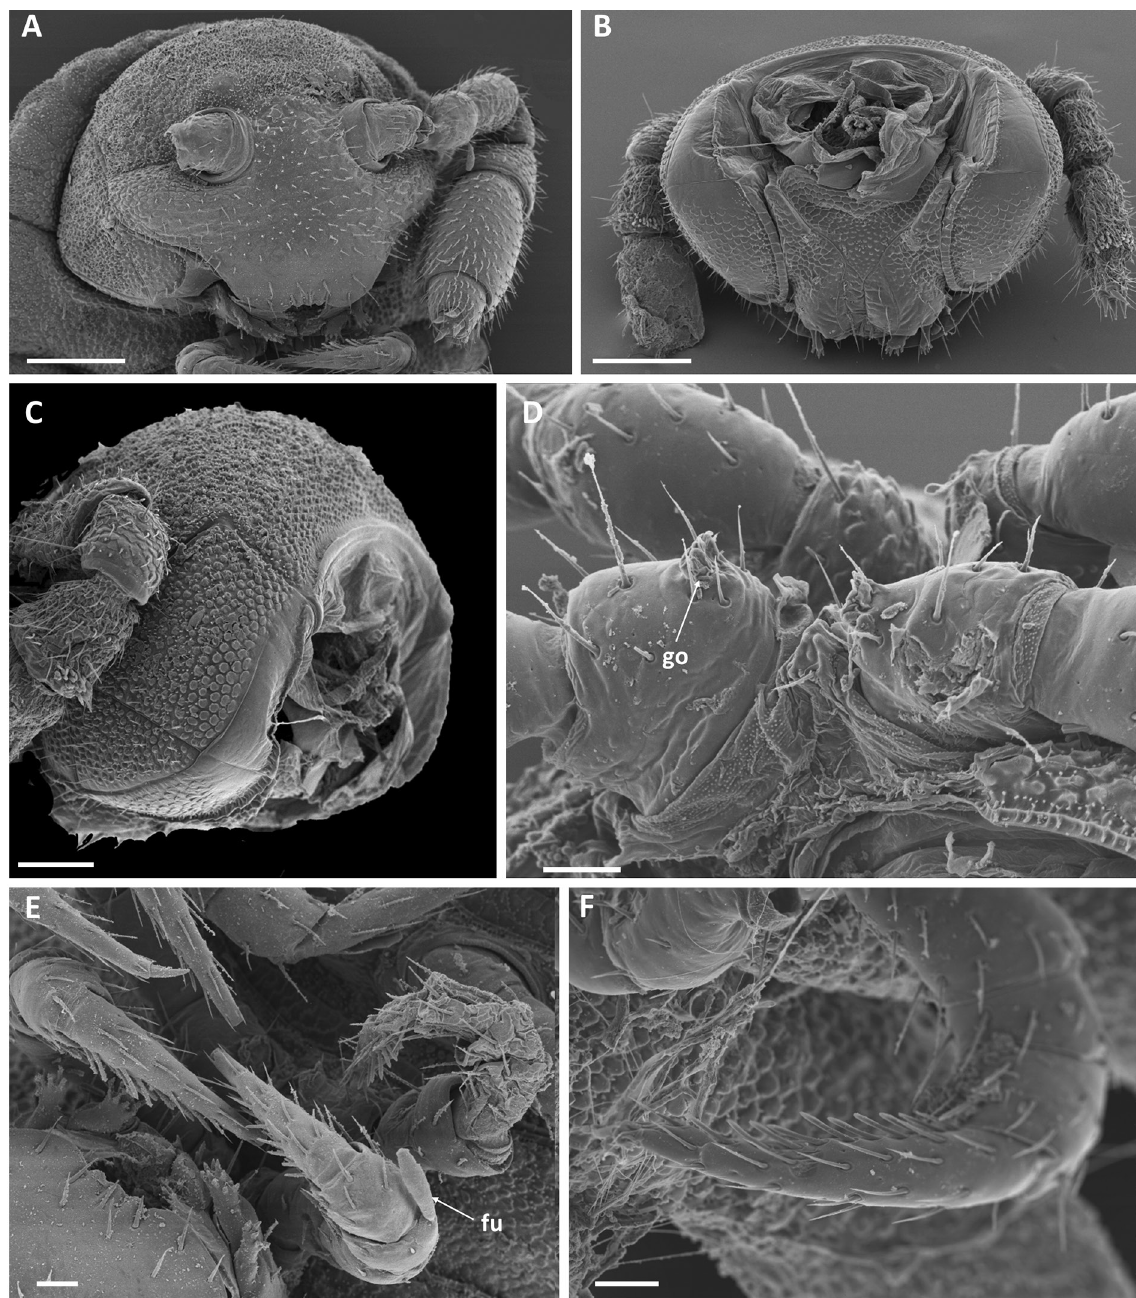
Fig. 2. Cryptocorypha geminiramus sp. nov. A–E . Paratype (NHMD 621824), ♂, from Kidatu. F . Paratype (NHMD 621829), ♂, from Mitu Mitato. A . Head, frontal view. B . Head, (sub)posterior view. C . Head, sublateral view (left side). D. Bases of first and second pairs of legs. E . First and second pair of legs. F . Leg of second pair, tarsus. Abbreviations: fu = epibiotic fungus, possibly Basiodiobolus sp.; go = gonopore. Scale bars: A–B = 0.1 mm; C = 0.05 mm; D–F = 0.02